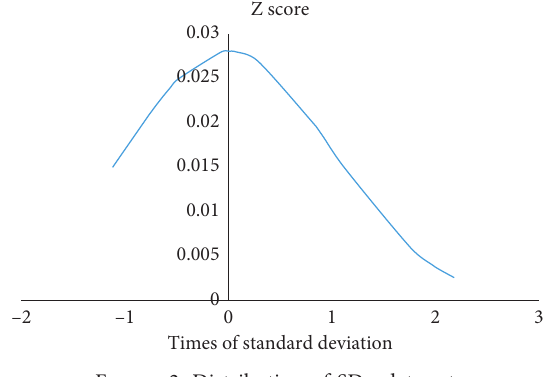
Figure 2: Distribution of SD +data set.